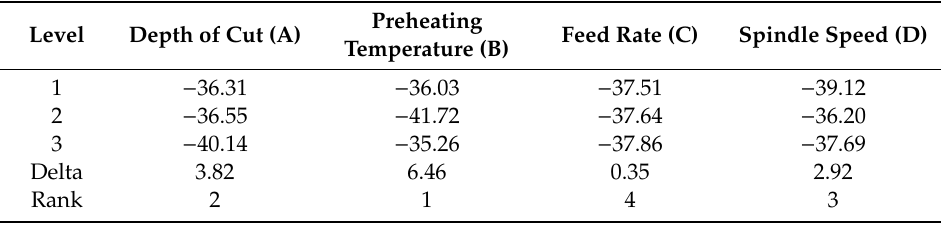
Table 8. The response table mean S/N ratio for the surface roughness according to the machining conditions.